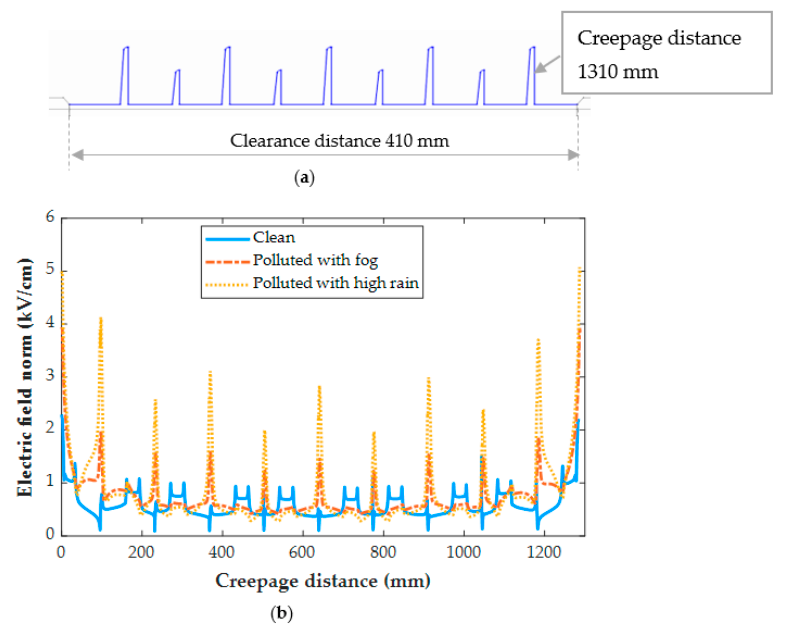
Figure 17. ( a ) Electric field path for insulator type I; ( b ) Electric field distribution for insulator type II under clean, polluted with fog, and polluted with high rain conditions.